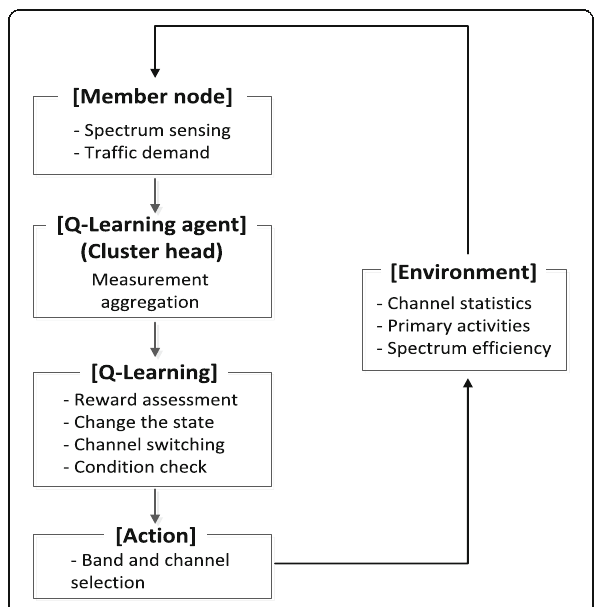
Fig. 4 Proposed Q-learning mechanism. The CH of the ad-hoc CR system is the agent of Q-learning, and the action is a selection of a tuple (band group and channel) when the PU is detected on the current band group and channel. The Q-learning agent (CH) designates the state from the information of member node and statistics of environment by the last action. From the Q-learning module, the Q-learning agent obtains the reward, change the Q-table and next action